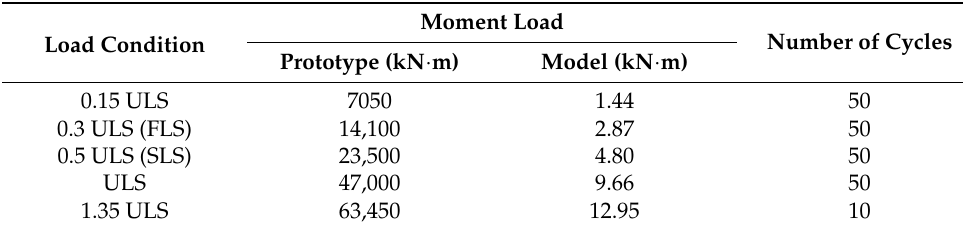
Table 5. Cyclic loading tests